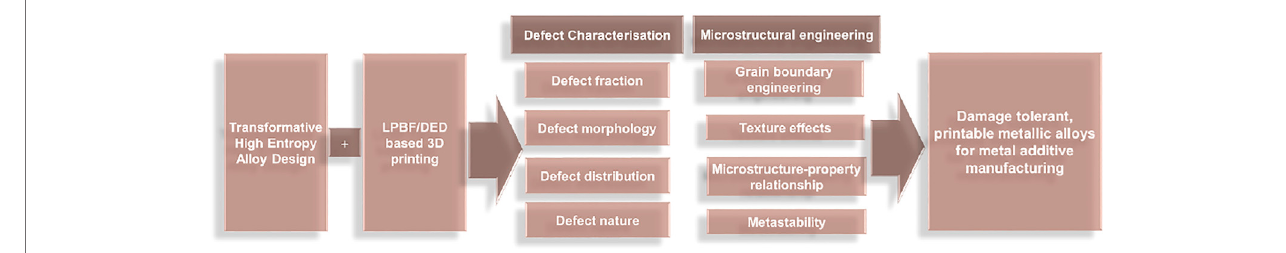
FIGURE 5 | Futuristic transformative high entropy alloy design for sustainable metal additive manufacturing.